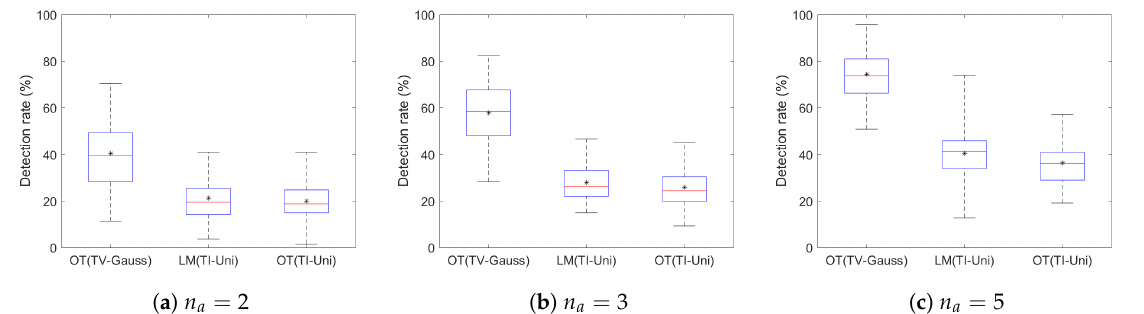
Figure 7. Statistical data for the performance comparison among OT (TV-Gauss), OT (TI-Uni), and LM (TI-Uni) with the variation in the number of UAVs: ( a ) n a = 2; ( b ) n a = 3; and ( c ) n a = 3. Mean values for the boxplots are indicated by the asterisk symbols.